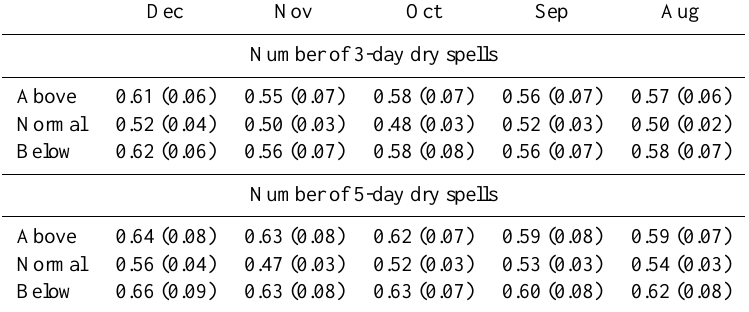
Table 1. ROC scores over the Limpopo region of the forecast anomalies of 3- and 5-day dry spells above the upper tercile, between the lower and upper terciles (normal) and below the lower tercile during DJF for different initial forecast dates (columns). The values between brackets are estimates of the ± 95% confidence interval from 1000 bootstrap samples. The bootstrapping does not provide exact symmetric confidence intervals around the mean (but they are close to symmetric), but here the average is shown to reduce the amount of data in the table.